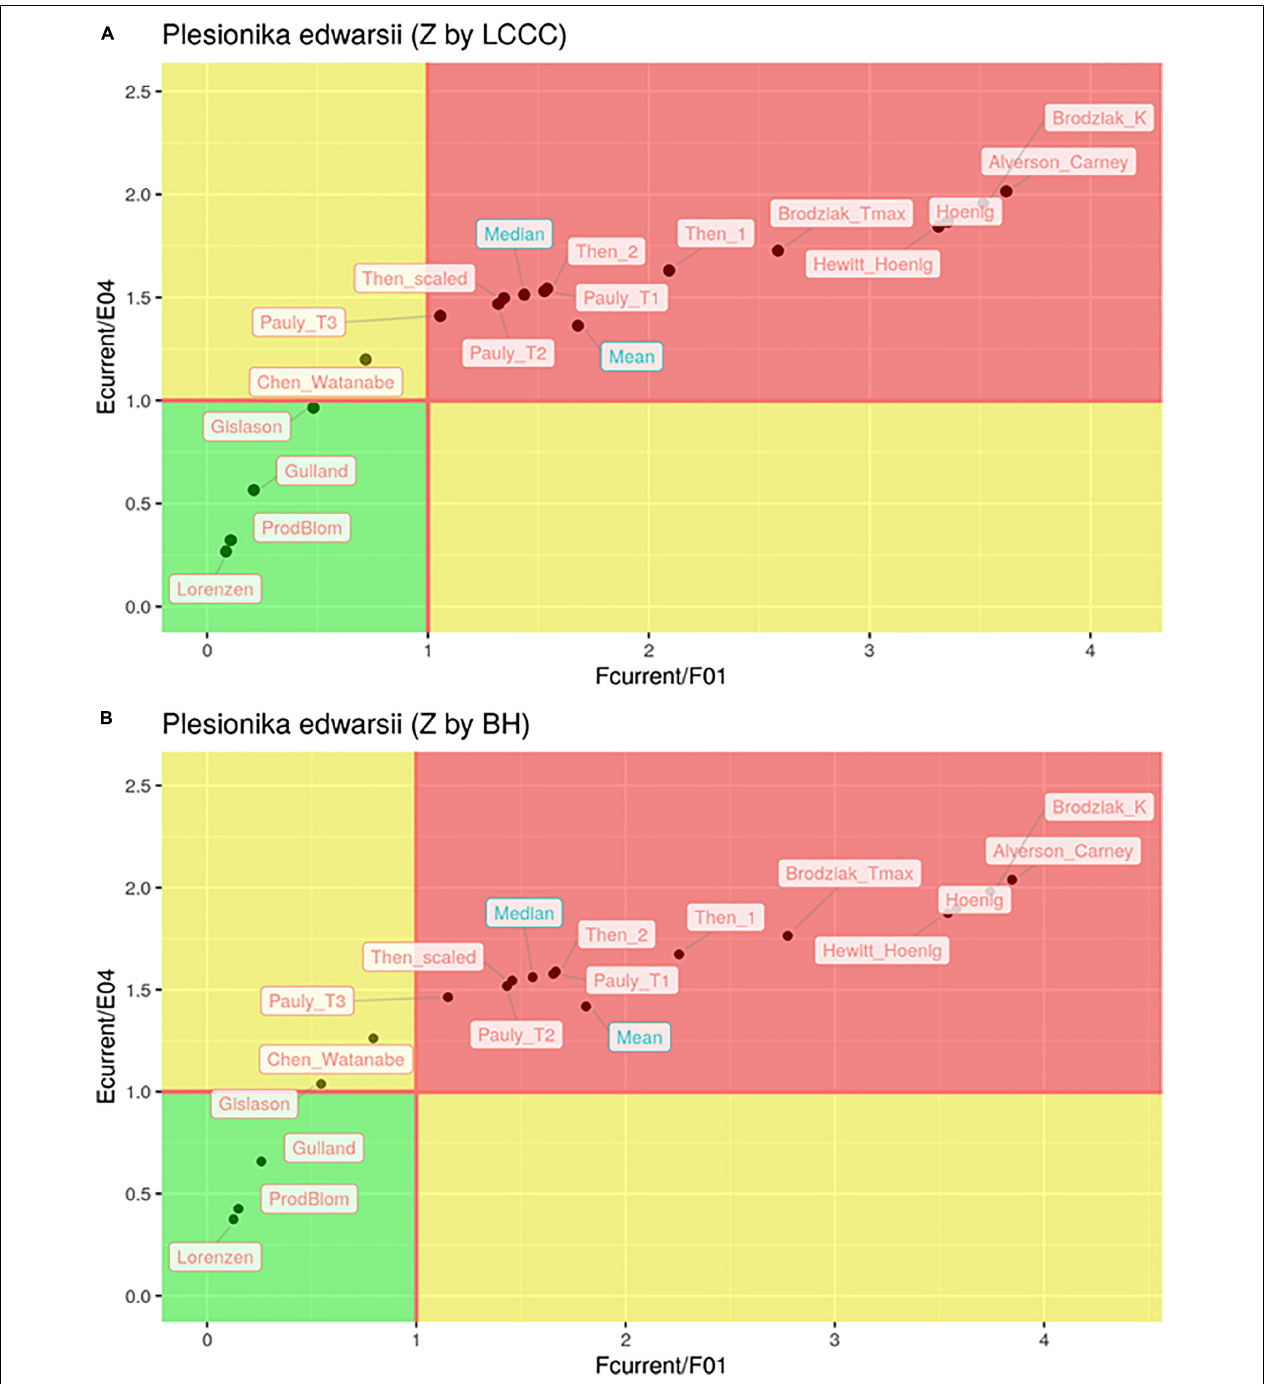
FIGURE 6 | Kobe plot of F F 0 . 1 and E E 0 . 4 for different estimations of natural mortality (M) with total mortality (Z) estimated by LCCC (A) or the Beverton and Holt formula (B)